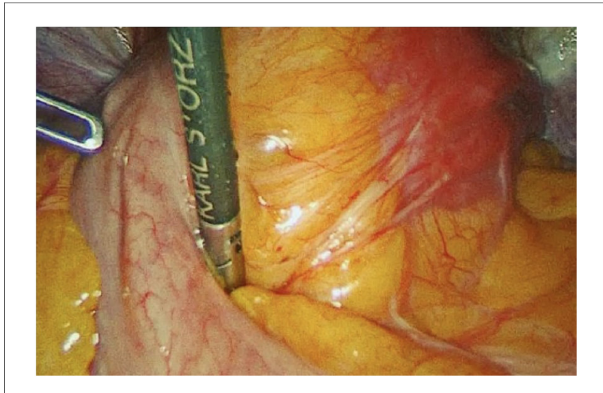
FIGURE 1 Adhesions through the posterior uterine wall and bowel. Sixteen months afterlaparoscopic myomectomy (Posterior uterine fi broid of6 cmFIGO